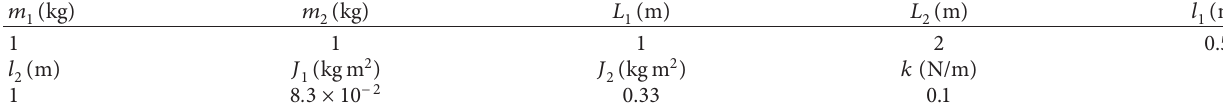
Table 1: Parameters of the underactuated horizontal spring-coupled two-link manipulator (UHSTM). ( kg ) m ( kg ) m 1 2